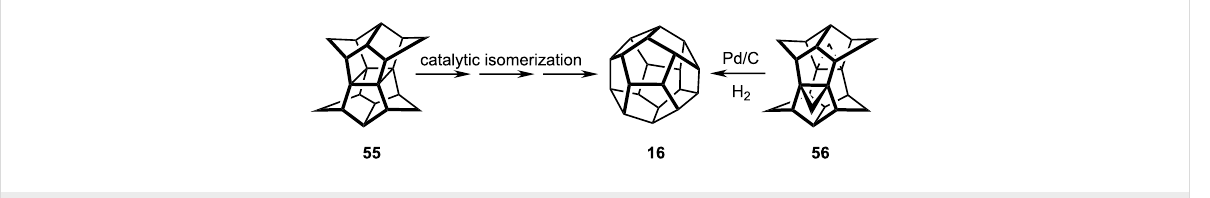
Scheme 9: Paquette´s synthesis of dodecahedrane 16 .